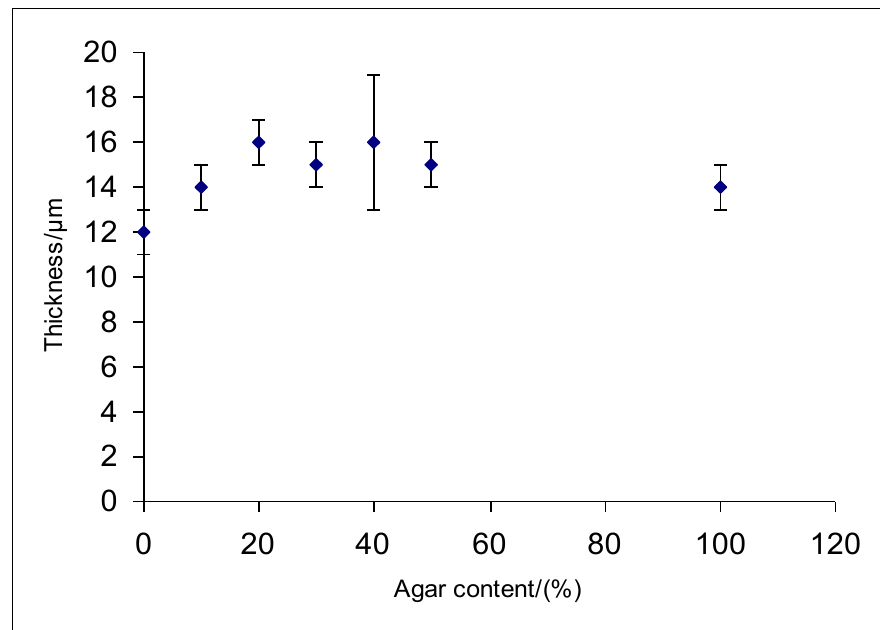
Figure 6: The thickness of the chitosan/agar blend film as a function of agar content.